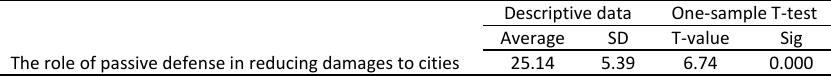
Descriptive data